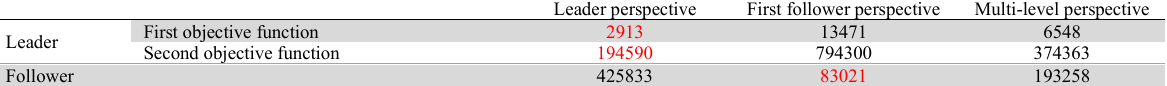
Objective functions of the proposed model from different points of view for second three periods